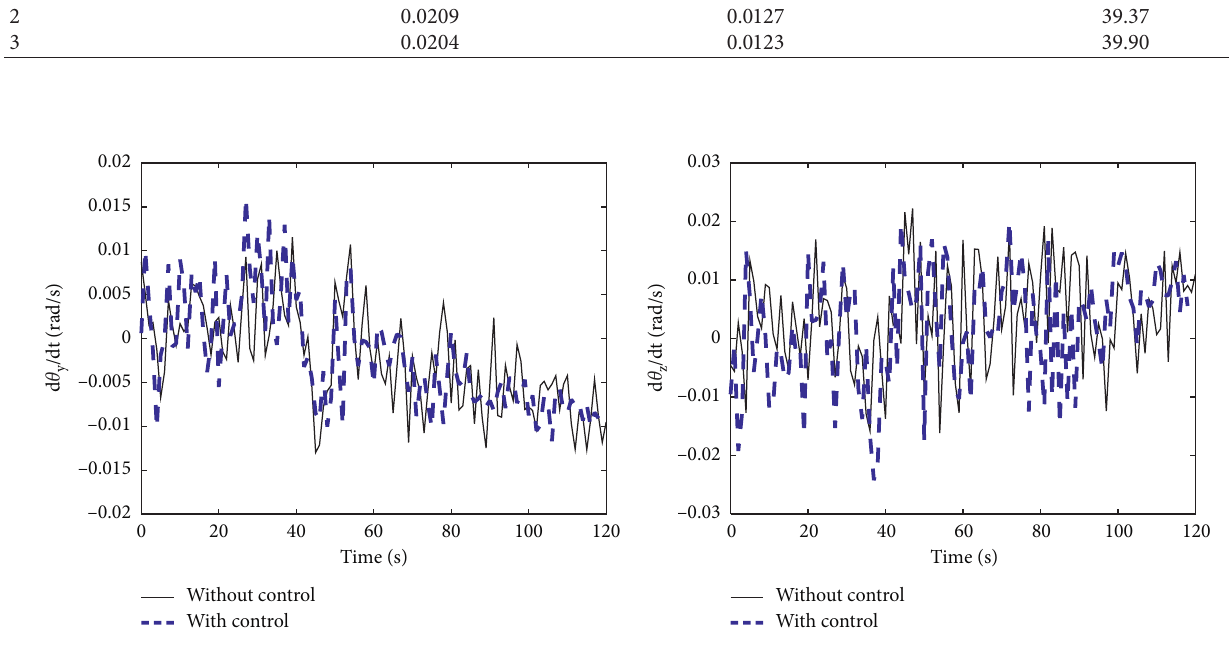
Figure 12: Experimental results of the elevation part in launching process for the 1st rocket: (a) the yawing angular velocity and (b) the pitching angular velocity.